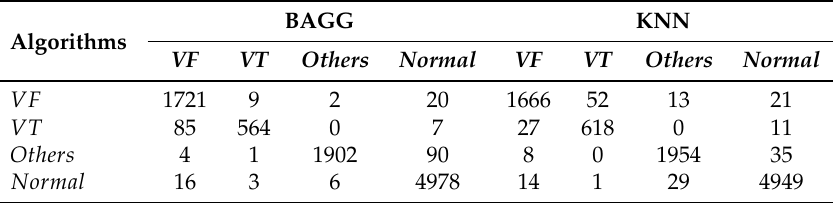
Table 4. Confusion matrix for classification of VF , VT , Others , and Normal using the BAGG and KNN